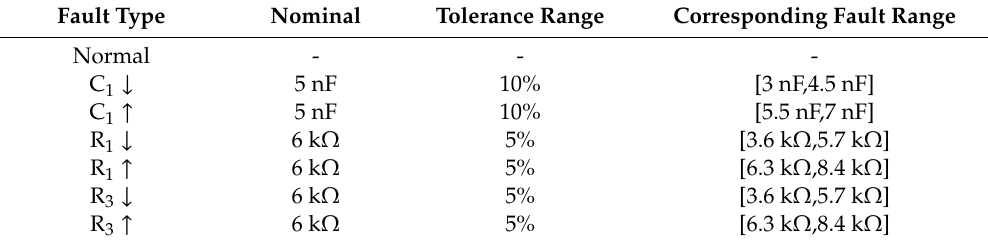
Table 5. Fault types of four-op-amp biquad high-pass filter circuit.